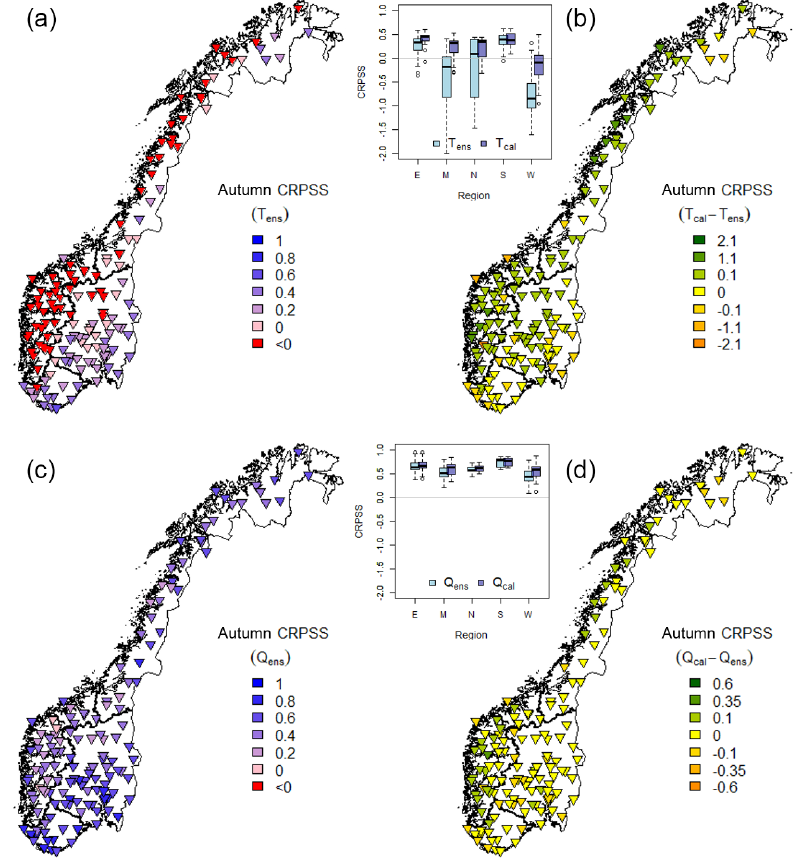
Figure 8. Autumn CRPSSs for uncalibrated forecasts are presented in panels (a) and (c) , where the darker blue color indicates an optimal performance (maximum CRPSS = 1.0), pink color represents a CRPSS of zero, and red a negative value. The differences in CRPSS between calibrated and uncalibrated forecasts are presented in panels (b) and (d) , where the green color indicates a positive effect of temperature calibration on the skill, yellow zero, and orange color indicates a negative effect. Temperature CRPSS is presented in (a) and (b) and streamflow CRPSS in (c) and (d) . The box plots of both calibrated and uncalibrated temperature and streamflow CRPSS show catchments grouped by region (Fig. 1). All results are presented for a lead time of 5